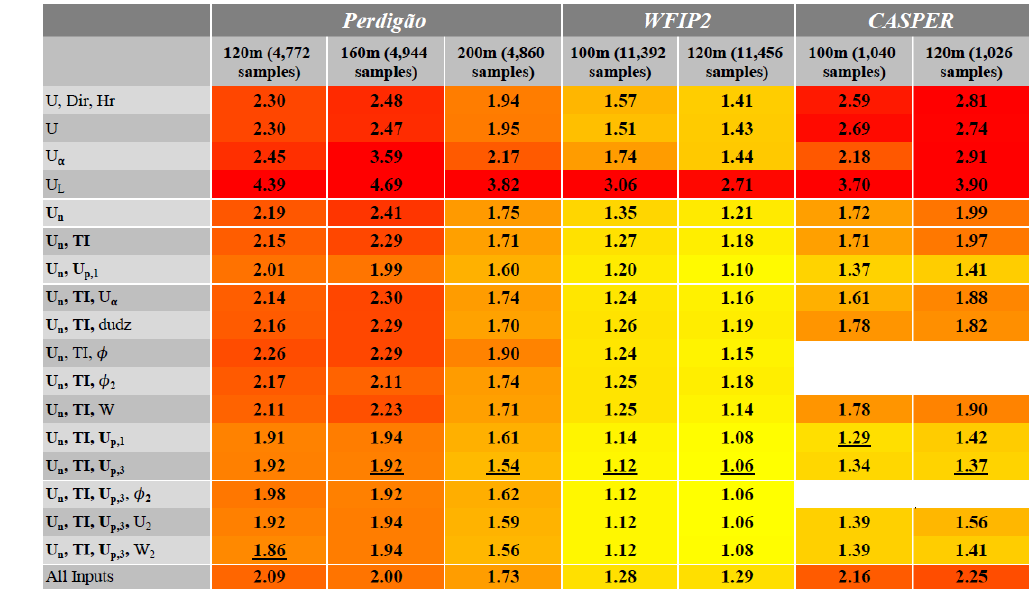
Table 1. Best MAPE per test case. For each height at every site, the case with the best result is underlined. Yellow is the highest accuracy, and red is the lowest. The total number of validation and testing samples is shown for